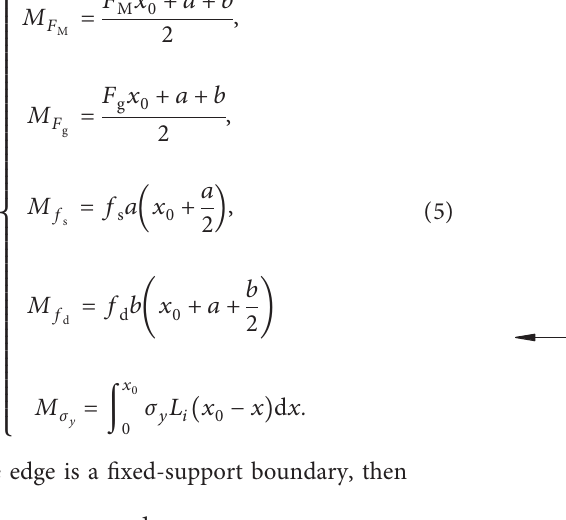
Figure 2: Direct roof force